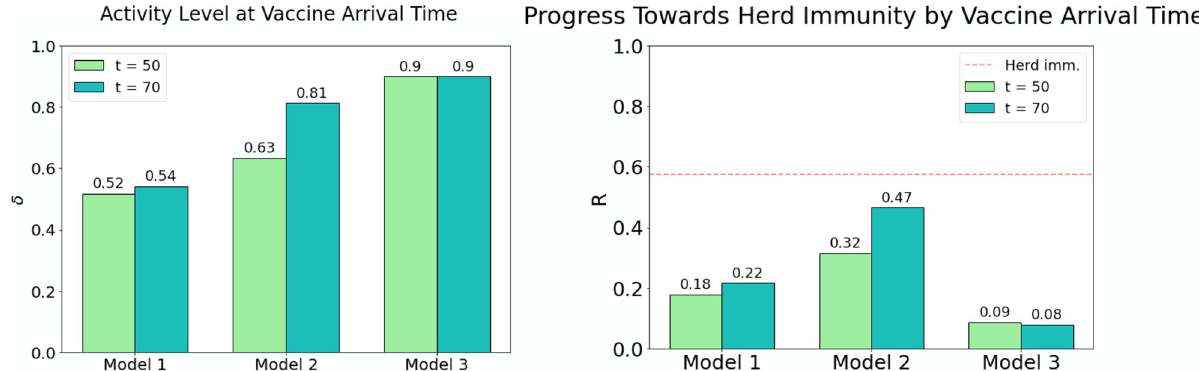
Fig 5. Forward projections on activity resumes and progress towards herd immunity. In the plot on the left we compare the level of activity in each of the three models at two potential vaccine arrival times ( t = 50,70). The strategy in Model 1 allows just over 50% of normal activity by t = 50 and hardly makes progress by t = 70. Model 2 allows more than 60% of normal activity levels at t = 50, which increases to over 80% over the following 20 periods. Model 3 features a reopening to 90% of normal activity levels which is held constant for the duration of the simulation. The plot on the right compares the progress towards herd immunity (red dashed line) in Models 1–3. Model 1 makes steady progress towards herd immunity, but pales in comparison to Model 2, which only requires a small fraction of the population to be vaccinated to bring an end to the epidemic. In Model 3, however, the absence of new infections combined with immunity loss causes the immunity level to decline as time